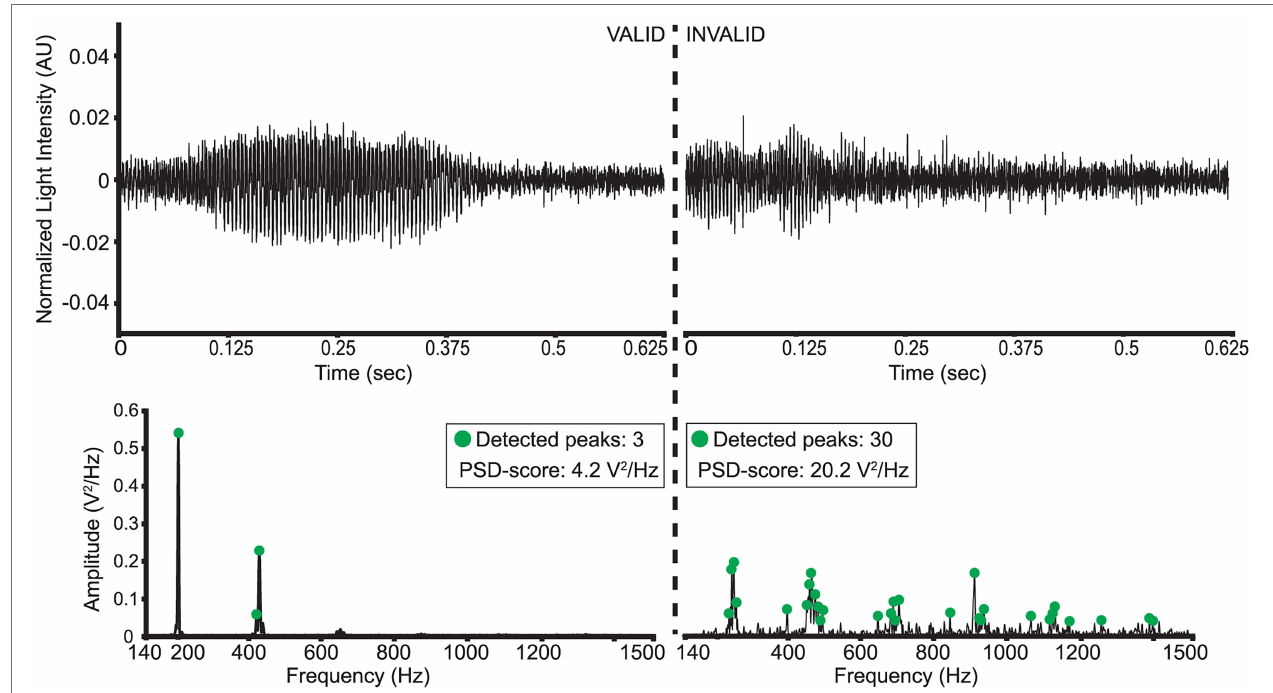
FIGURE 6 | Illustration of a “valid” and “invalid” D. melanogaster wingbeat signal and their respective